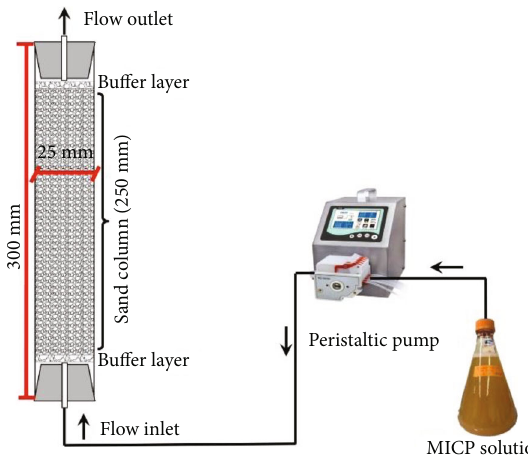
Figure 2: Schematic of the experimental